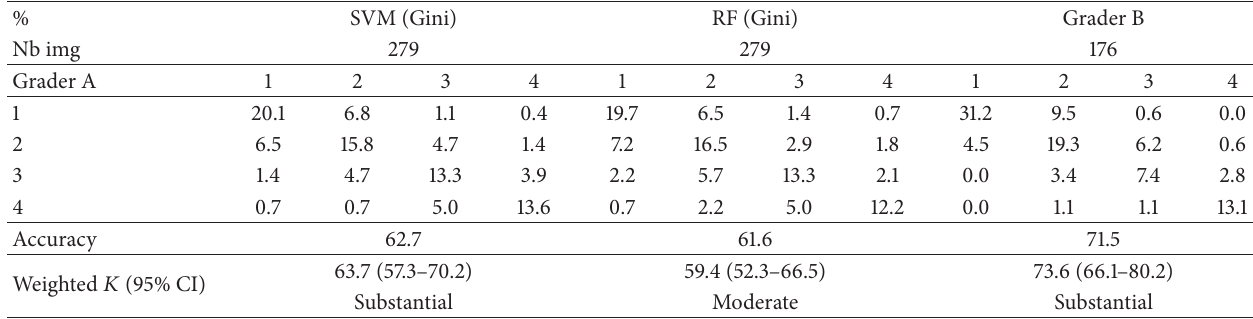
Table 5: Confusion matrix in percentage for grading ( {1} versus {2} versus {3} versus {4} ).